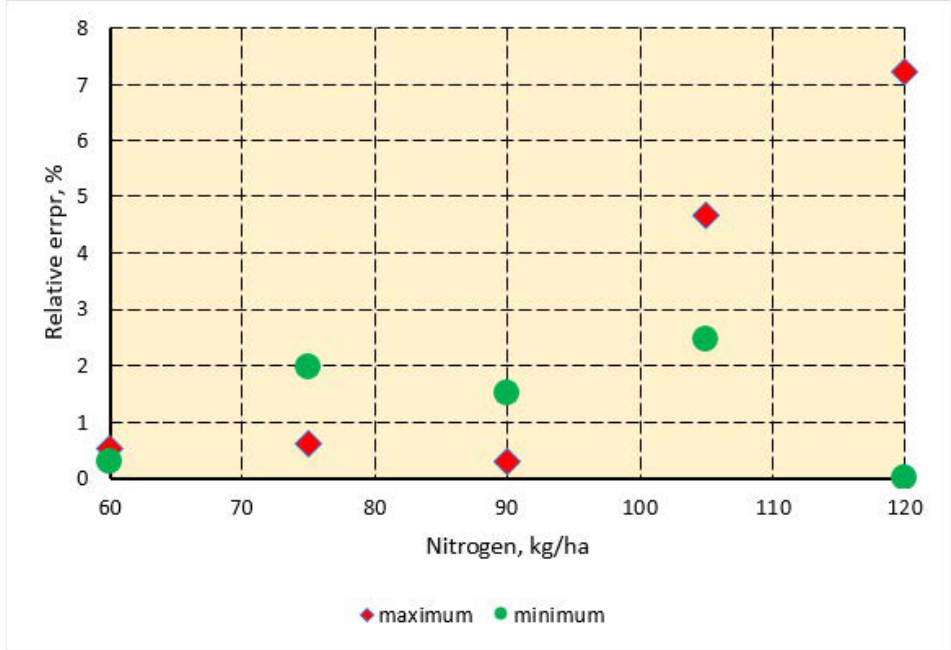
Figure 5. The relative error (the preceding crop is maize).